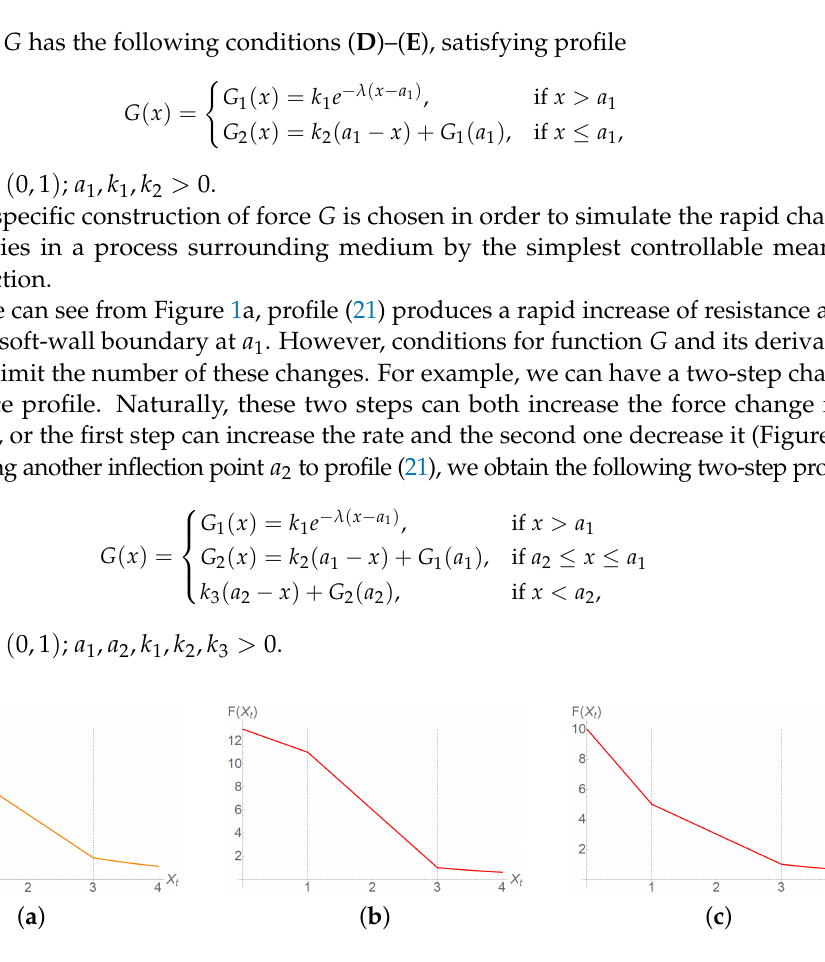
Figure 1. Force F profiles. ( a ) Single soft-wall. ( b ) Double “increase–decrease” soft-wall. ( c ) Double “increase–increase” soft-wall.